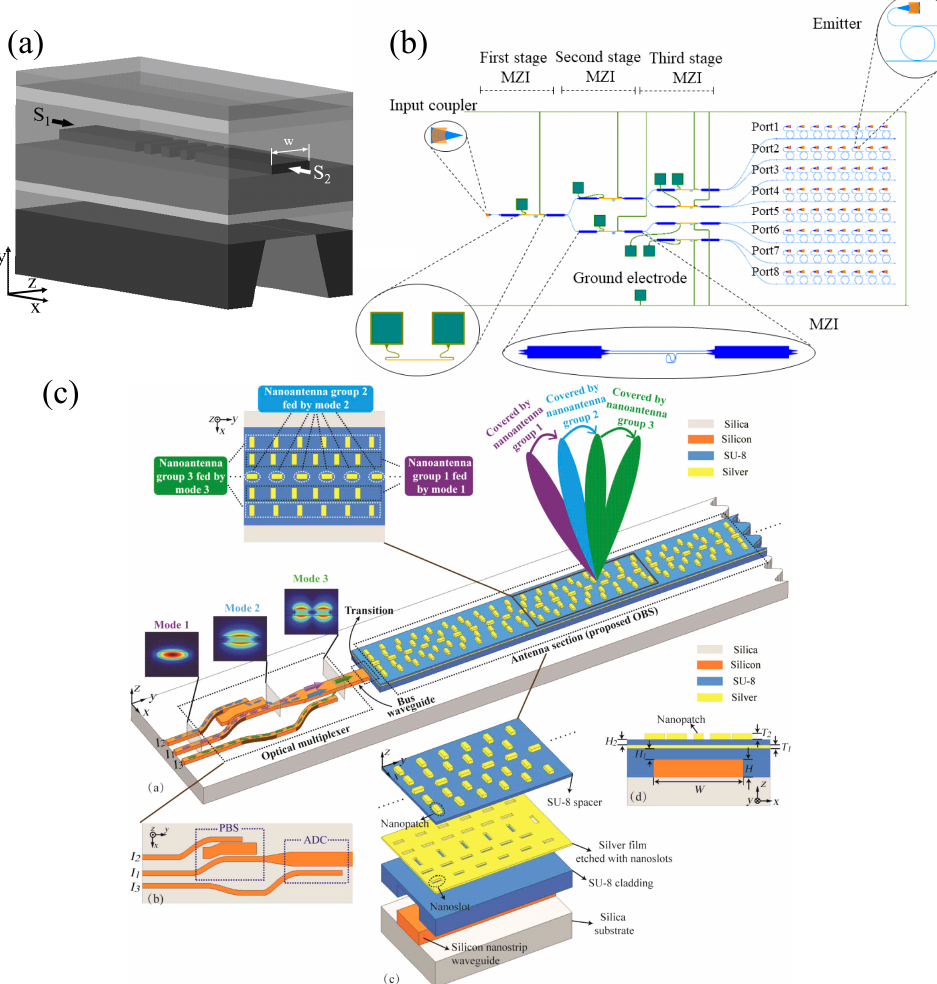
Figure 9. Some structures for beam forming and steering. ( a ) A bidirectional wide-angle WGA for OPAs [118]. ( b ) A 2D 8 × 8 optical scanning structure with wavelength division filters and emission array. Reproduced from [68] published by IEEE, 2019. ( c ) A polarization-division and spatial-division multiplexed nanoantenna array. Reprinted with permission from [37] © The Optical Society.